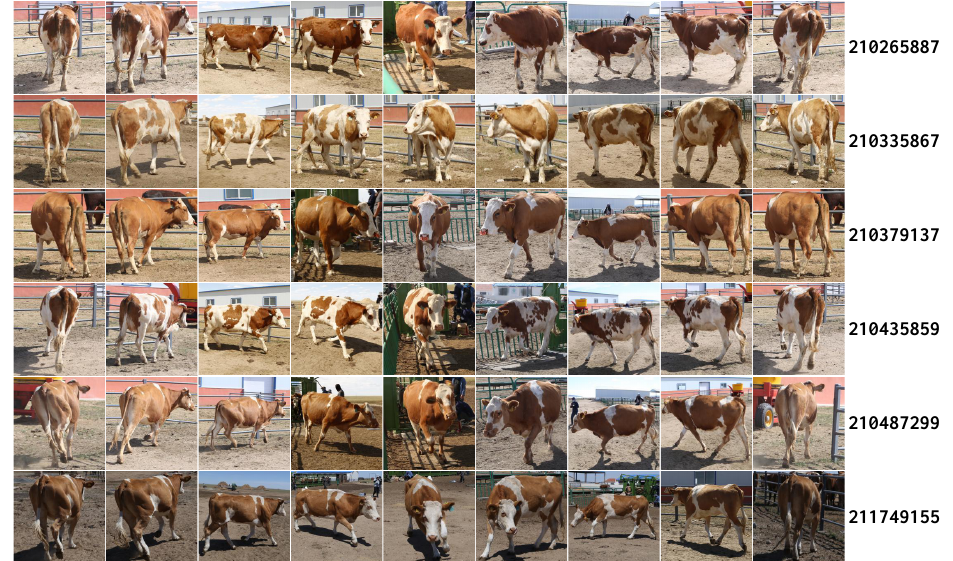
Figure 2. CNSID100 dataset examples. The CNSID100 dataset contains images of Chinese Simmental from multiple views, such as front, back, left, and right perspectives, on standing postures in the real farming environment for cattle identification. It contains 11,635 images of 100 identities, about 100 images with at least 3 main views per identity. Samples of several individuals in the CNSID100 dataset are given, and the most notable is the variance of imagery perspective, standing postures, and illumination conditions. The numbers on the right are the ID codes of the cattle. Best viewed in